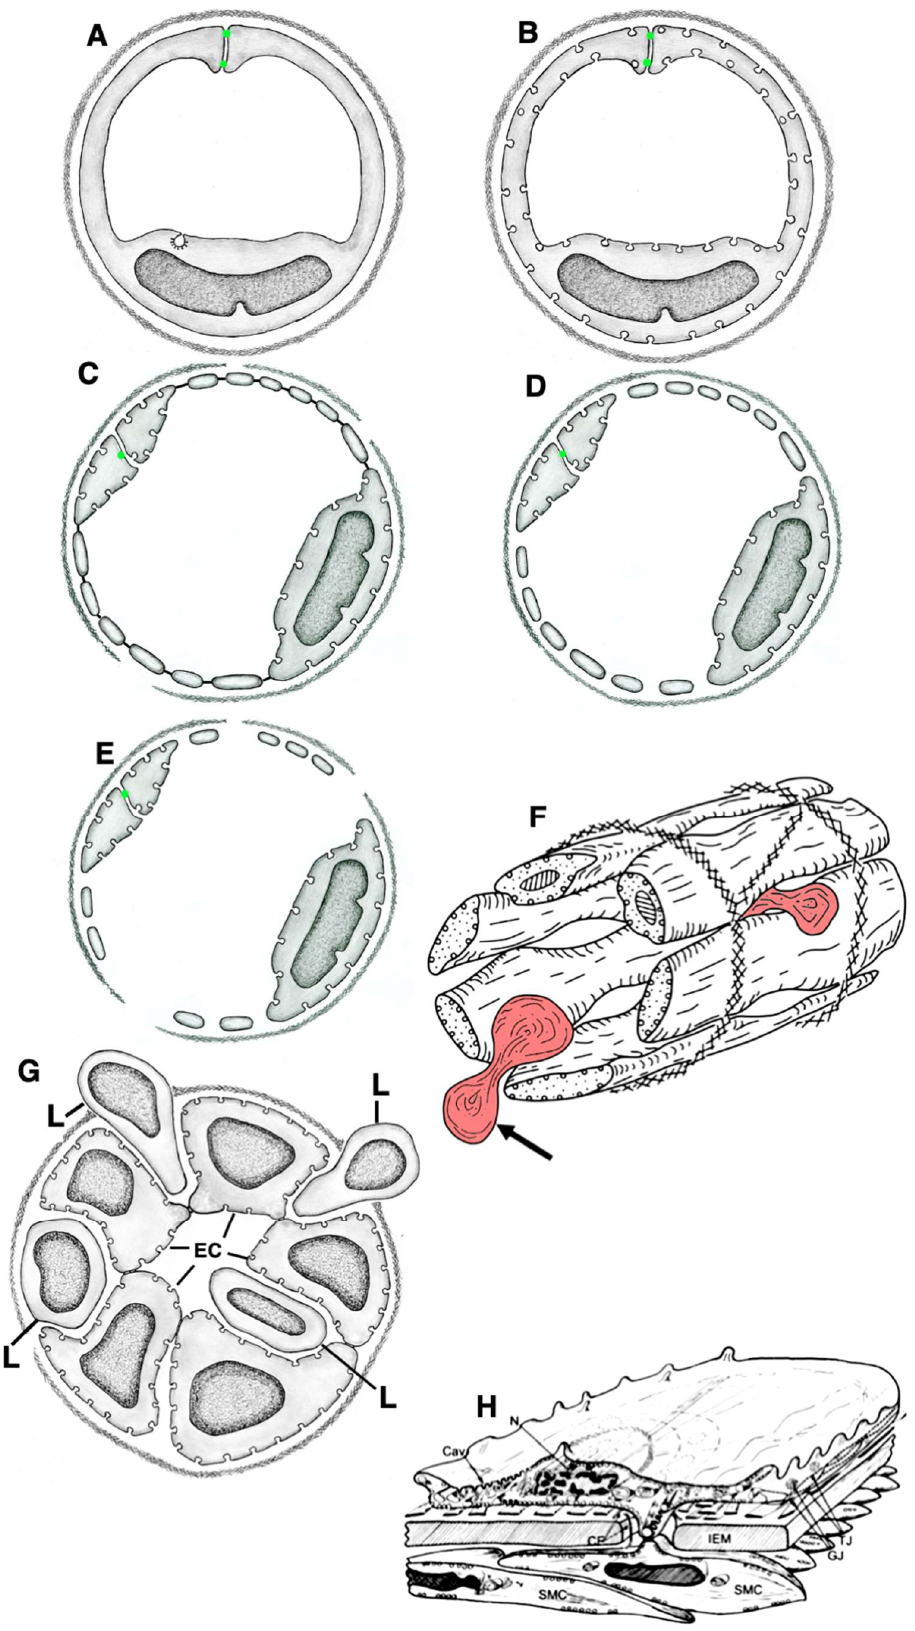
Figure 6. Different types of endothelium. ( A ) The continuous thin oligocaveolar endothelium with close contacts (in brain capillaries and in lymphatic vessels). ( B ) The continuous thin multicaveolar endothelium with close contacts (in blood capillaries of the heart, striated muscles, uterus, and skin).